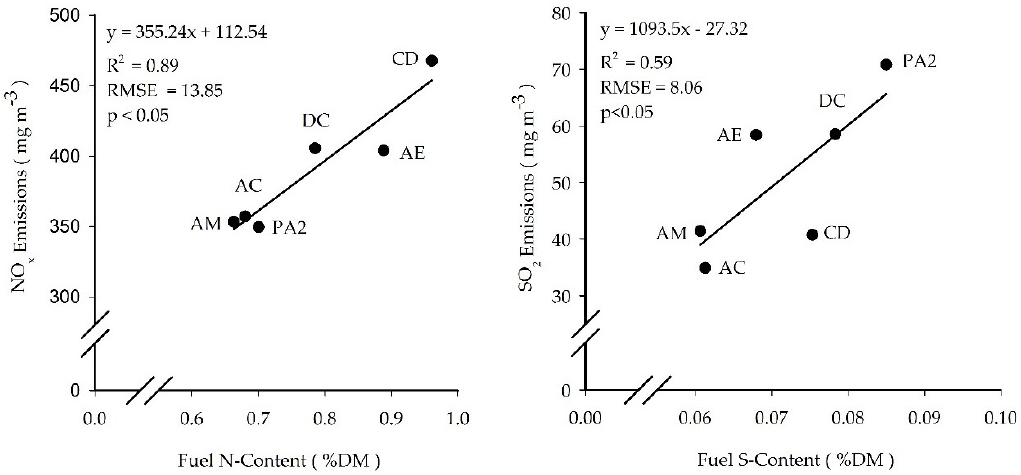
Figure 3. Correlation between mean values for NO x emissions and N concentration in the fuel and for SO 2 emissions and S concentration in the fuel.